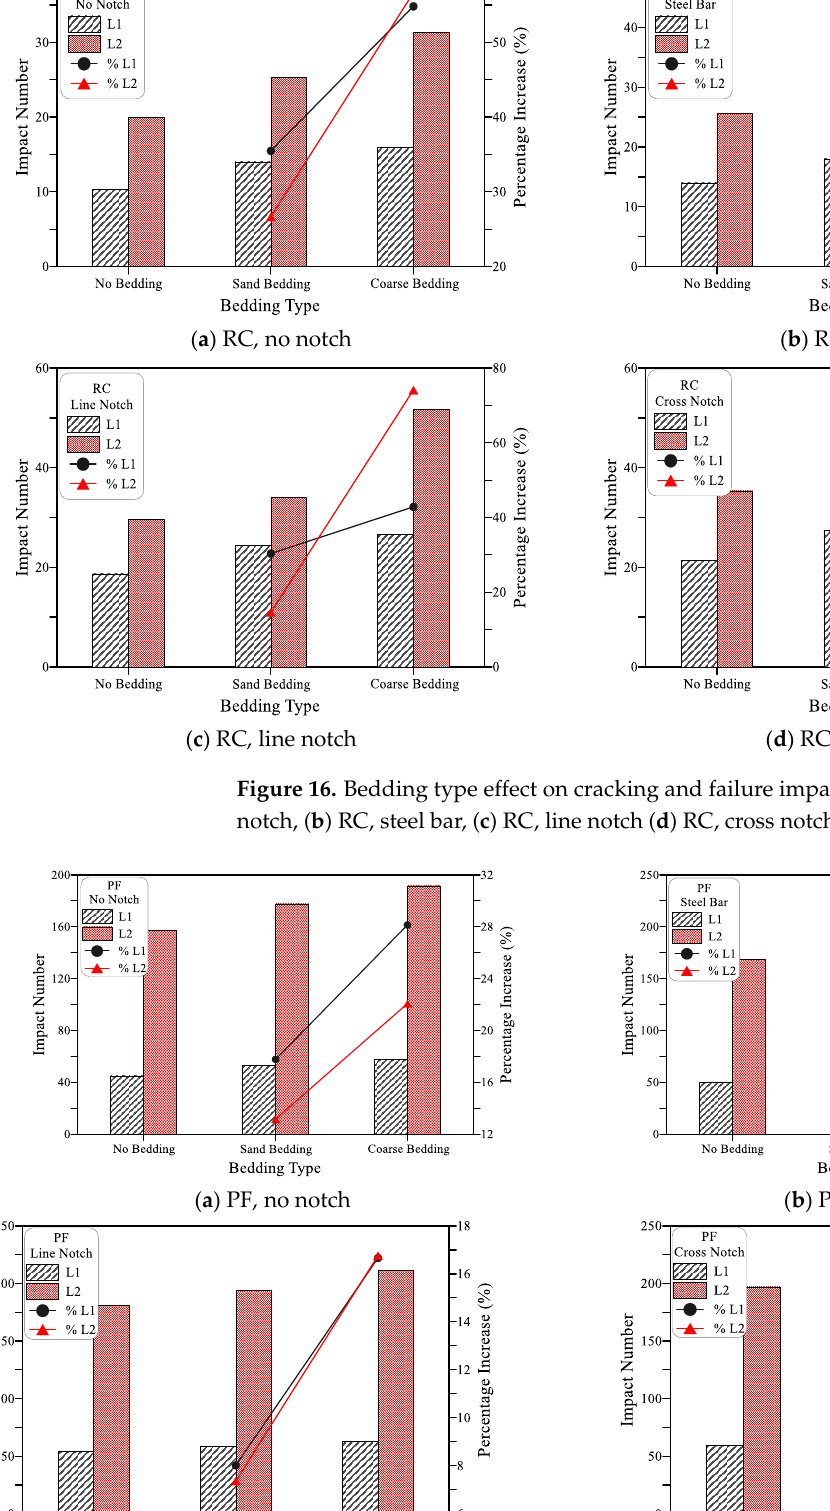
Figure 18. Bedding type effect on cracking and failure impact numbers of SF specimens ( a ) SF, no notch, ( b ) SF, steel bar, ( c ) SF, line notch ( d ) SF, cross notch The increase in the retained impact numbers due to the use of bedding materials was also reported by previous researches [28,53]. This increase is directly attributed to the re- lief in the absorbed impact energy by the disc specimen obtained from the partial energy absorbance of the bedding materials. The compaction of the bedding materials absorbs a part of the applied impact load leading to lower stresses in the disc specimen after each impact blow. Therefore, the degradation of concrete that leads to the cracking and failure